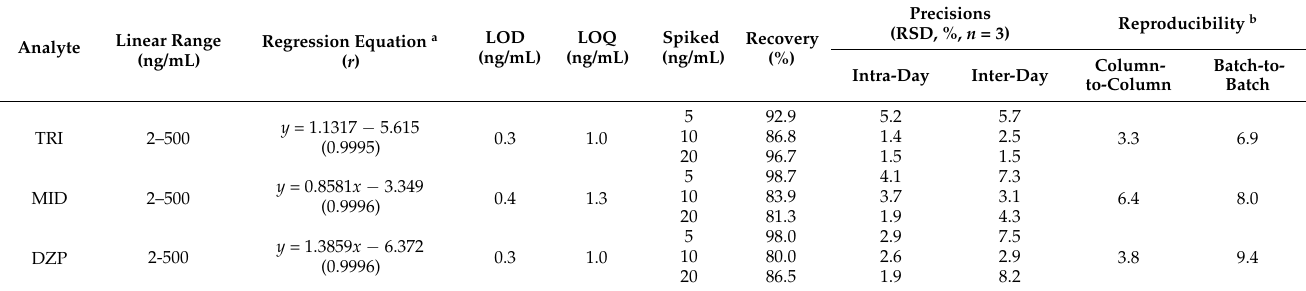
Table 2. Linear range, regression equation ( r ), LOD, LOQ, recovery, precisions and reproducibility of the proposed method. Regression Equation a Analyte Linear Range (ng/mL) ( r )